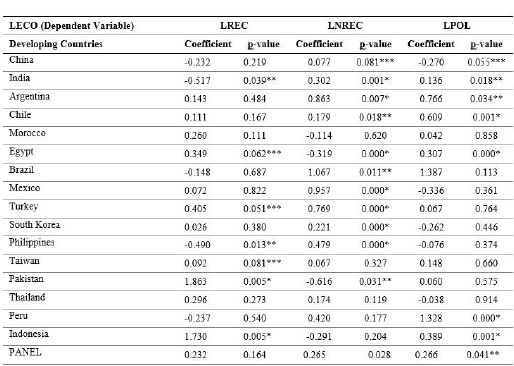
Table 9: AMG Cointegration Estimator Test Results